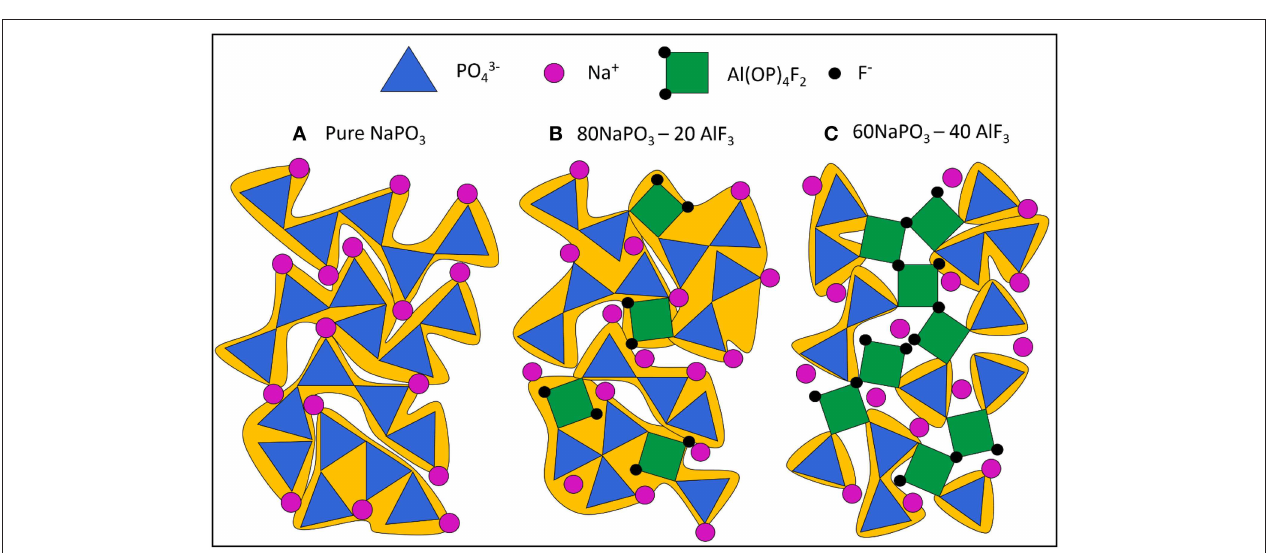
FIGURE 14 | Manually drawn schematic of (A) pure NaPO 3 glass, all Q 2 chains and an average chain length of 5 phosphate tetrahedra (large CRR, ≈ 70 nm 3 , 10 3 phosphate tetrahedra for real system); (B) 80NaPO 3 – 20AlF 3 , Q 1 , and Q 2 species present and an average chain length of 2.5 phosphate tetrahedra (smaller CRR, ≈ 20 – 40 nm 3 , 300 – 600 formula units in real system) and (C) 60NaPO 3 – 40AlF 3 , Q 1 , and Q 2 species present and an average chain length of 1 phosphate tetrahedra (smallest CRR, ≈ 10 nm 3 , < 200 formula units in real system). Highlights the Al—F—Al bridges leading to high energy barrier for some